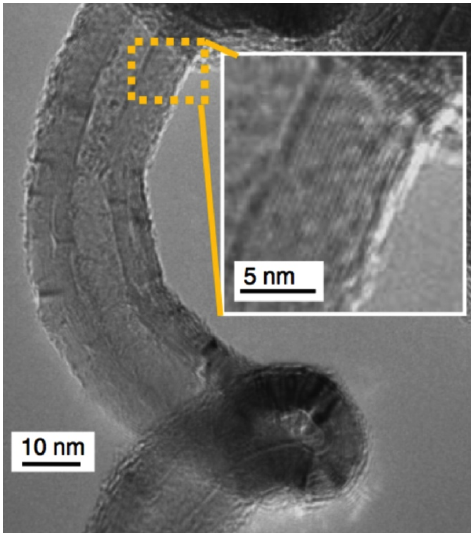
Figure 6. TEM image of multi-walled CNC [19]. Reprinted with permission from [19], Copyright 2008 Japan Society of Applied Physics.